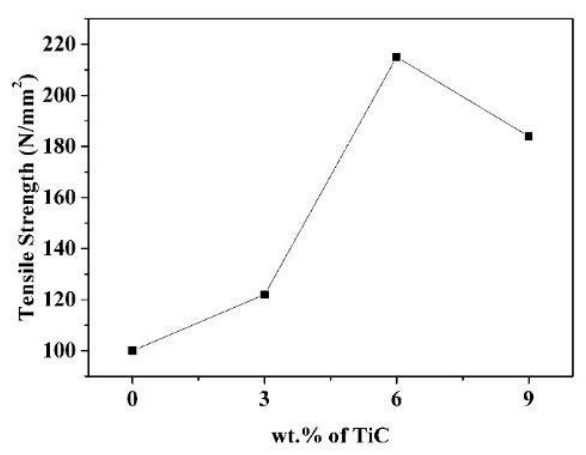
Fig. 8. Effect of TiC addition on the tensile strength of Al7075/TiC